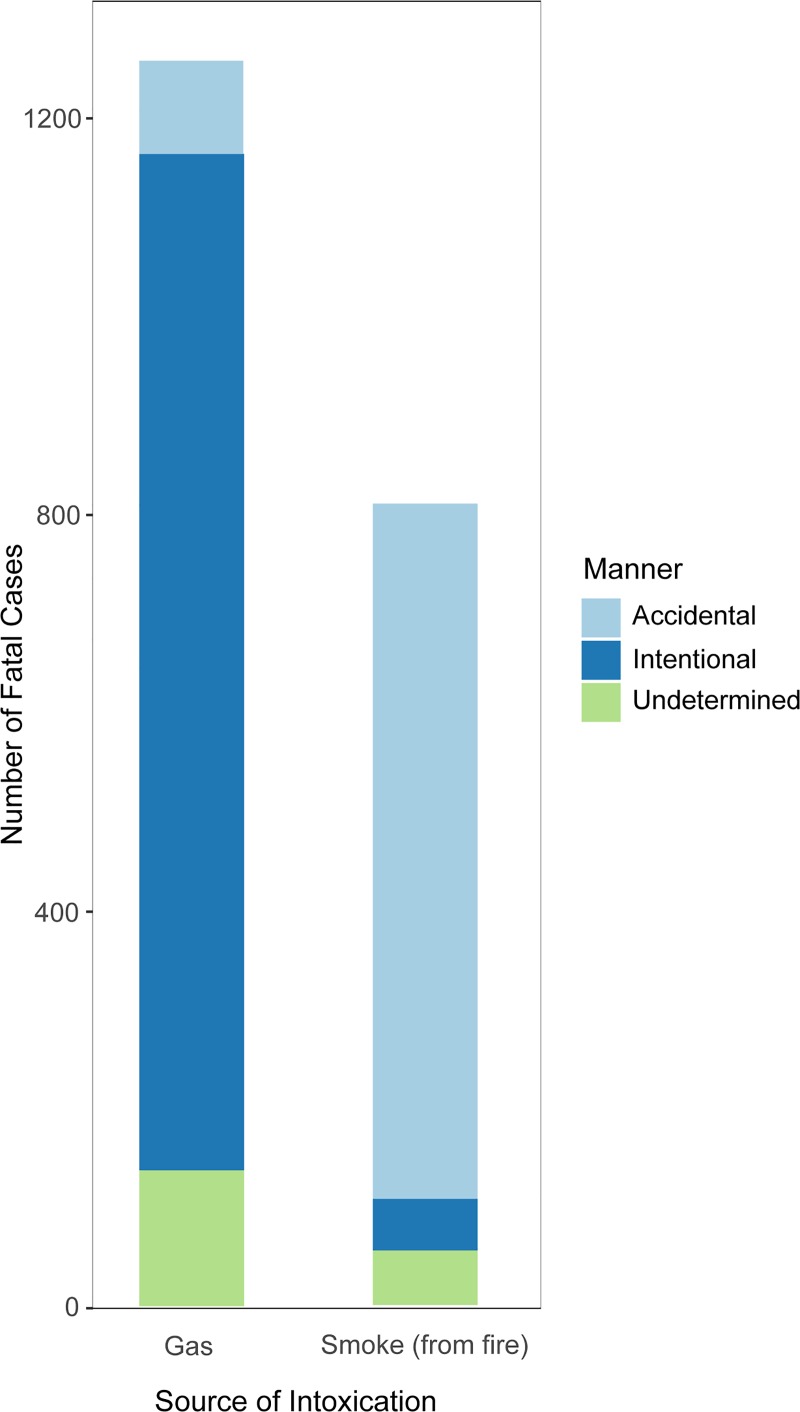
Number of fatalities by type of exposure and manner of death.